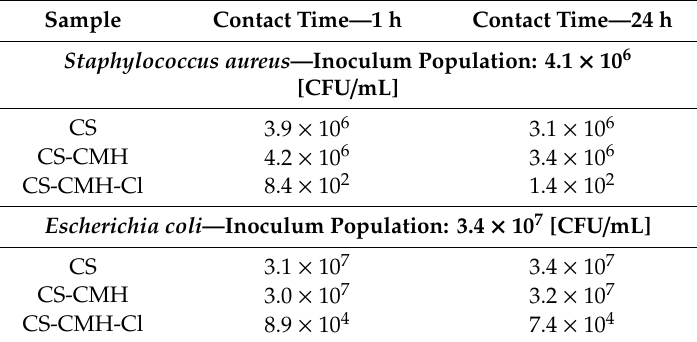
Table 5. Theantibacterialeffectofobtainedmaterialsagainsttwostrainsofthebacteria: Staphylococcusaureus and Escherichia